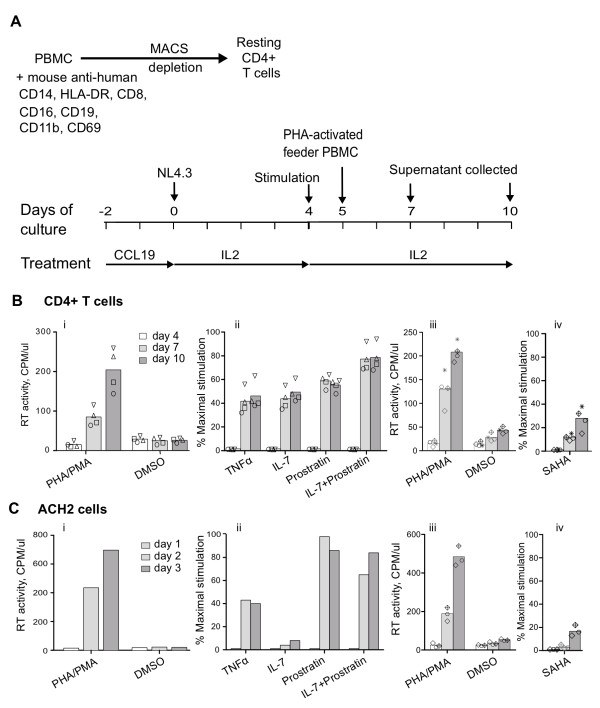
Virus production from latently infected CCL19 stimulated cells. (A) Schematic diagram of the experimental protocol used for infection and restimulation of CCL19-treated resting CD4+ T-cells. Resting CD4+ T-cells were cultured for 2 days with CCL19 and infected with NL4.8 and then restimulated with different activation agents at day 4 post- infection (PI). PHA-stimulated activated PBMCs were added at a ratio of 2:1. The cultures were maintained in IL-2 alone. Supernatant was harvested at day 7 and 10 PI to detect RT activity. (B) RT activity (CPM/μl) was measured following incubation of CCL19-treated infected CD4+ T-cells with (i) PHA/PMA (maximal stimulation) or with DMSO, (ii) TNFα, IL-7, prostratin and the combination of IL-7 with prostratin (expressed as percentage of maximal stimulation), (iii) PHA/PMA or DMSO (from different donors for vorinostat (SAHA) experiments) or (iv) vorionostat (SAHA) expressed as percentage of maximal stimulation (from (iii)). The mean (column) and individual data (open symbols) from four donors are shown. (C) The latently infected cell line ACH2 was also incubated with the same stimuli as in (B) and supernatant collected at day 1, 2 and 3 post stimulation. The mean (column) and individual data (open symbols) from three separate experiments, following activation with vorinostat (SAHA) are shown.